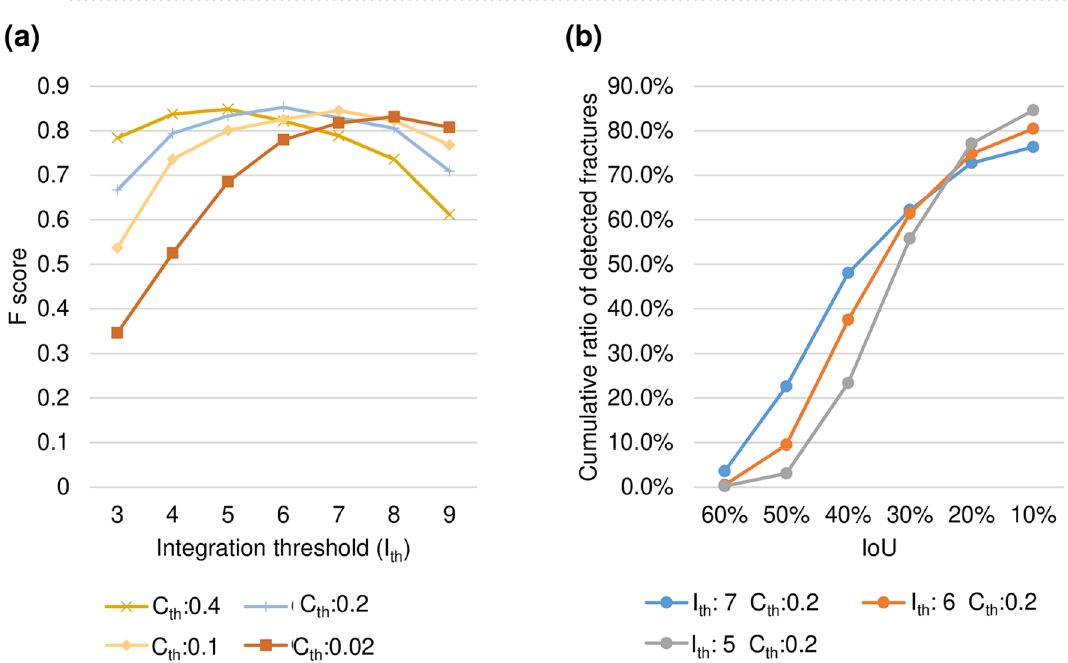
Figure 4. The 3D visualization of fractures. ( a ) Ground truth fractures. ( b ) Automatically detected fractures.